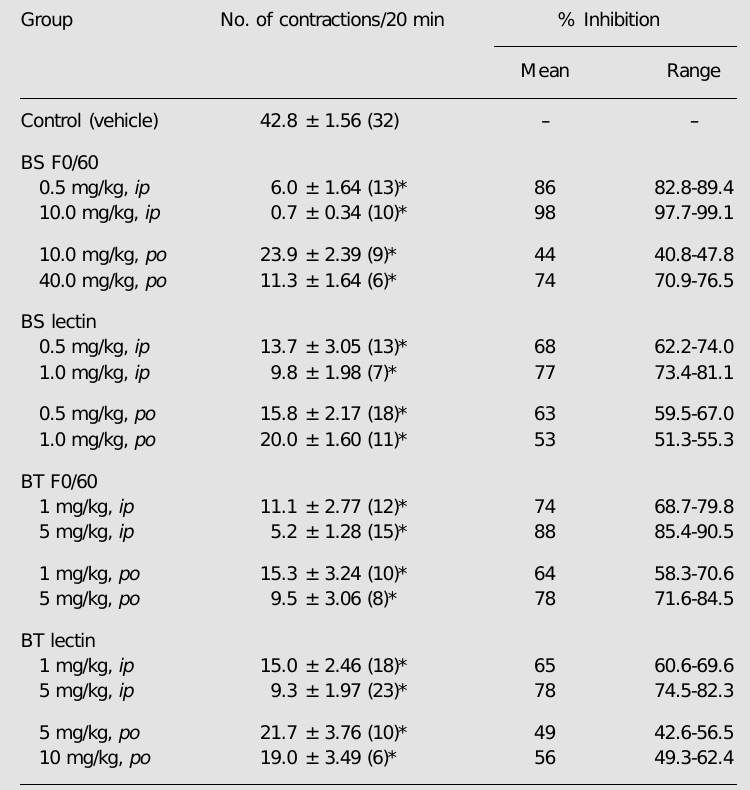
Table 1. Effects of F0/60 and lectin fractions from Bryothamnion seaforthii (BS) and B. triquetrum (BT) on acetic acid-induced abdominal contractions in mice.